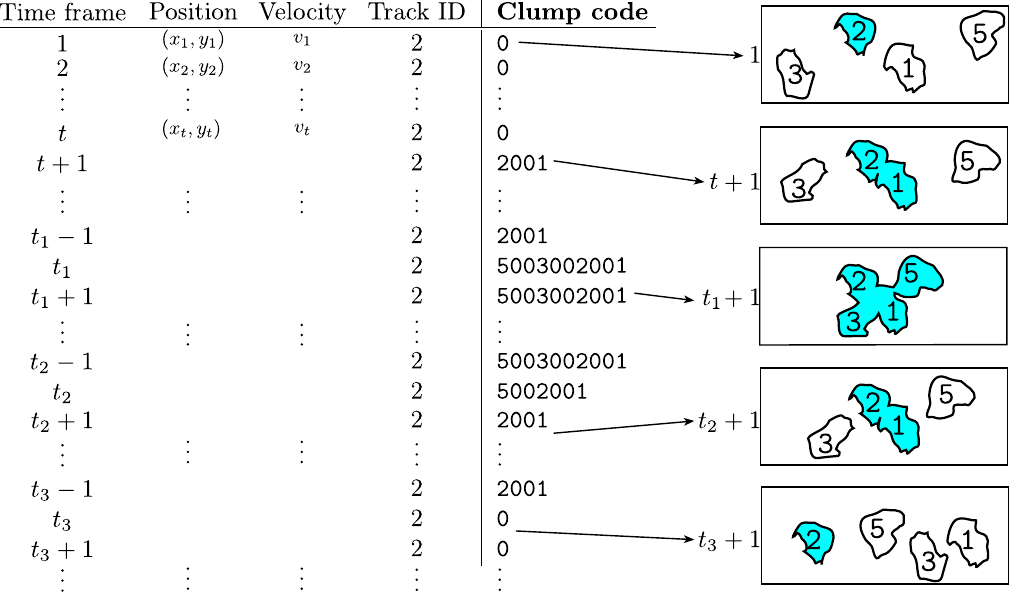
Figure 5. Illustration of clump codes incorporated to a particular track information. The table shows the information of track 2 spanning along certain time frames and in several clumps . The right column shows a representation of the cells at different time frames, and their involvement in different clumps , highlighted in